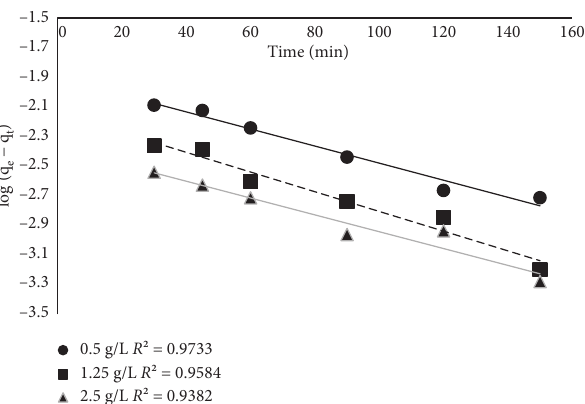
Figure 4: First-order rate kinetics for the sorption of methylene blue (MB) onto Ginkgo biloba leaf (GBL) powder.